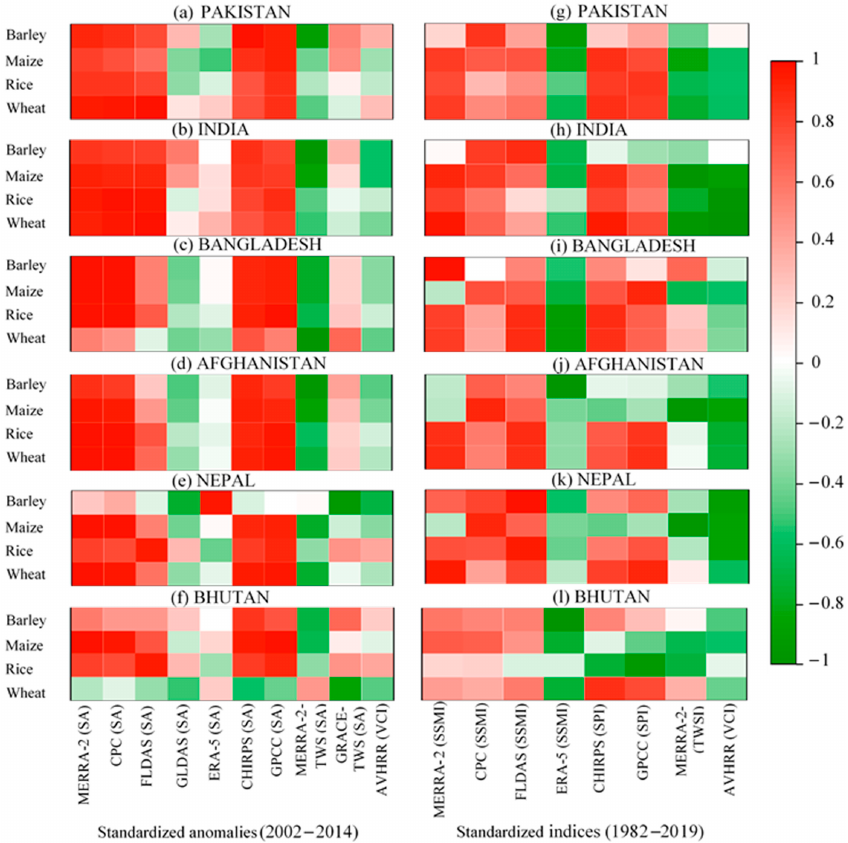
Figure 8 . ( a – l ) The relationships between the yield anomaly index (YAI) data and drought index/anomaly data for South Asian countries. In the case of the long-term YAI from 1982–2019 (g–l), the above-mentioned products indicate a miscellaneous relationship. MERRA-2, CPC, FLDAS, CHIRPS, and GPCC showed mixed but significant associations against different crops in all countries, except Bhutan.